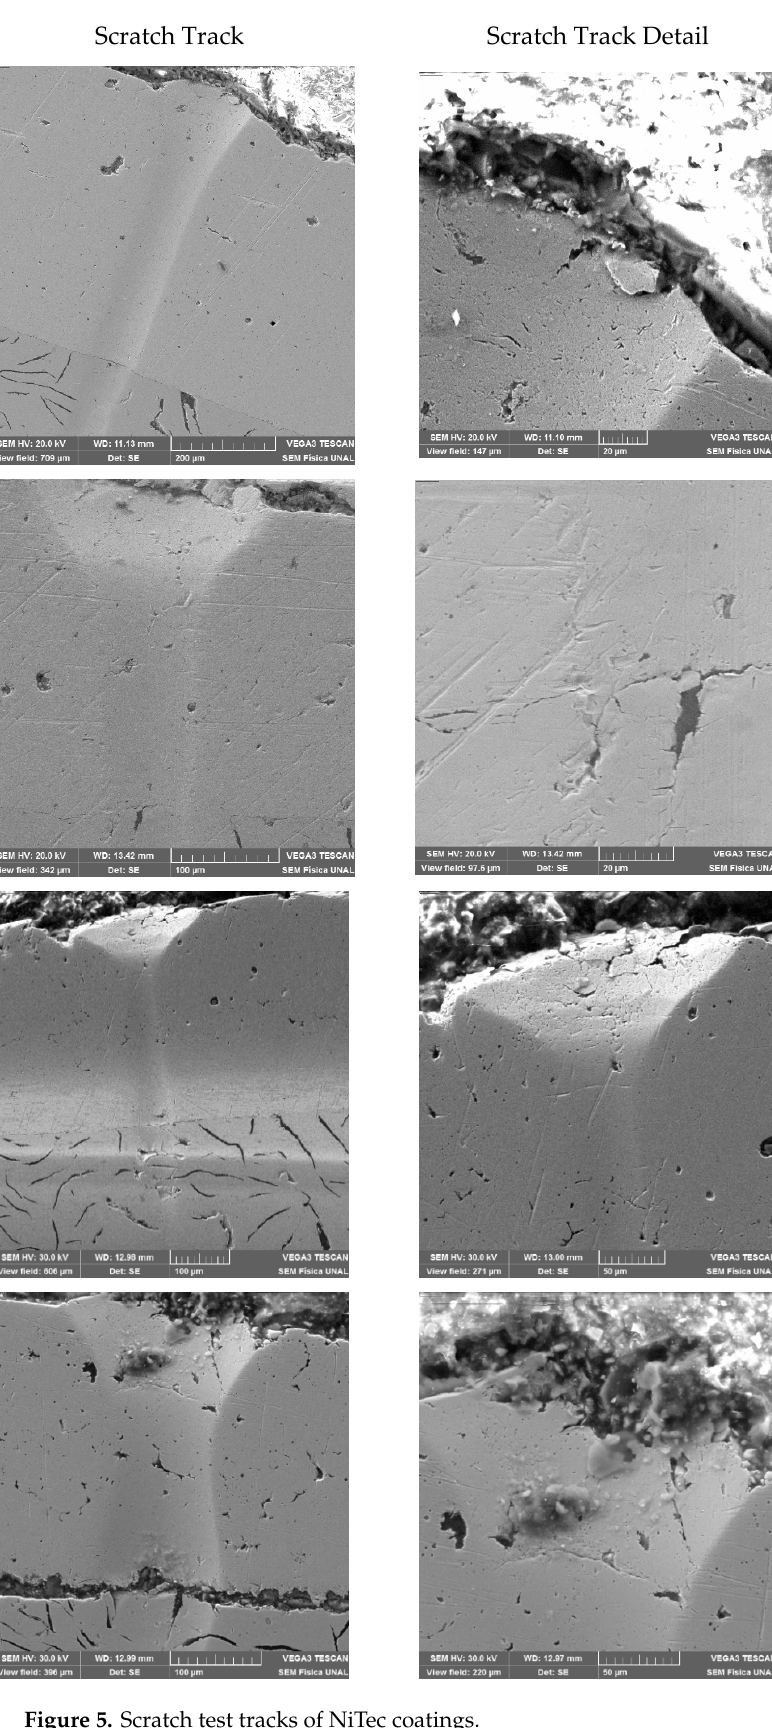
Figure 5. Scratch test tracks of NiTec coatings.